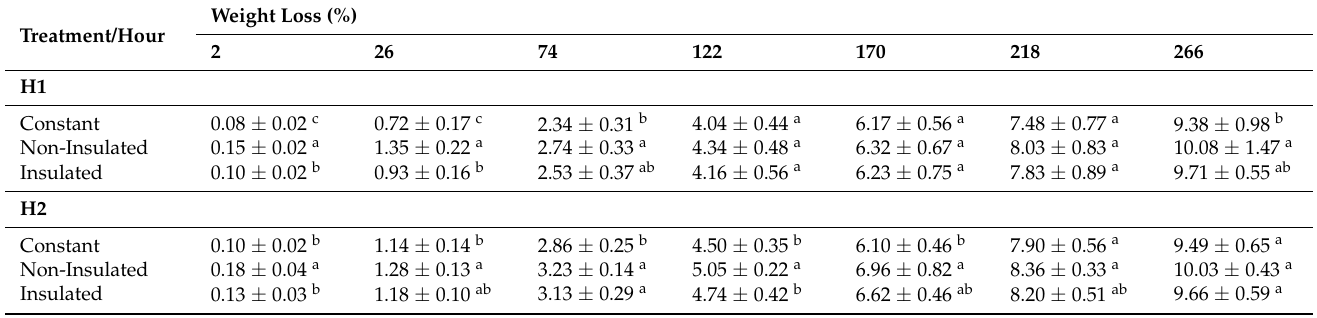
Table 4. Weight loss (%) of mango fruits after simulated handling treatments in first